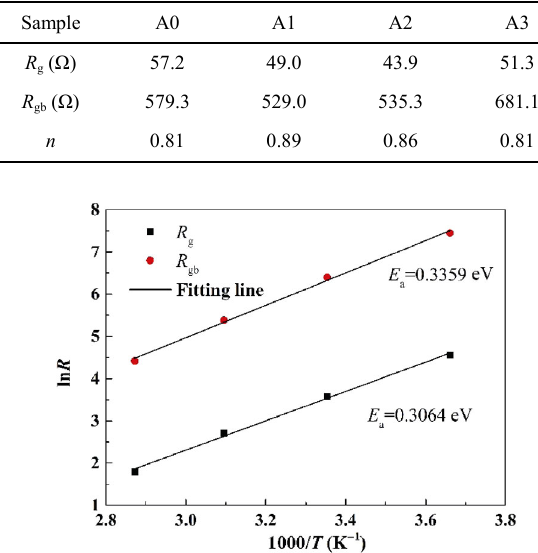
Fig. 12 Temperature dependence of impedances from R g and R gb for A2 sample.